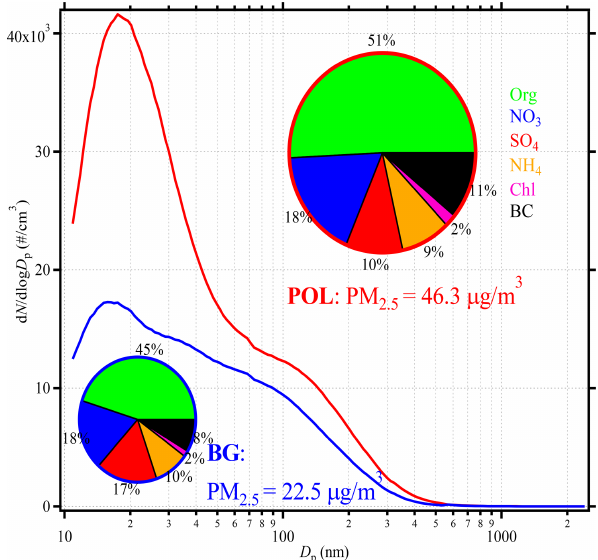
Figure 3. Average aerosol particle number size distributions (red and blue curves) and mass fractions of aerosol chemical species in PM 2 . 5 (pie charts with red and blue outlines) during the POL (in red) and BG (in blue)